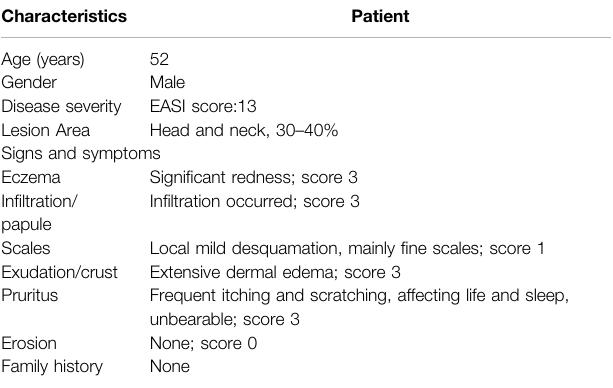
TABLE 3 | Baseline and clinical characteristics of patient with